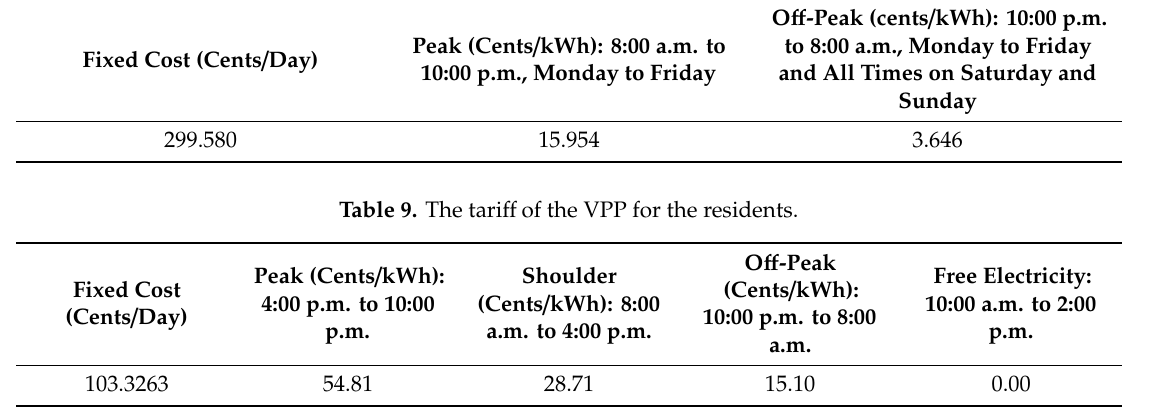
Table 8. The costs of the RT16 tari ff .